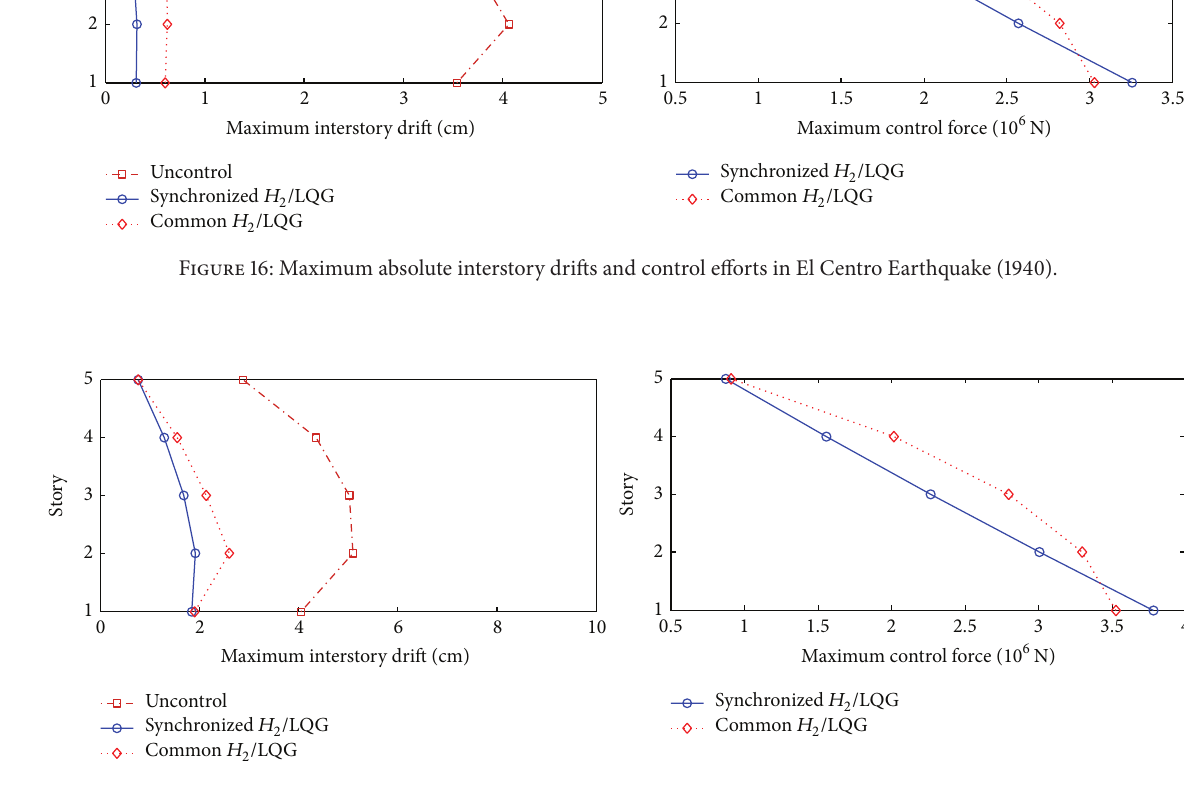
Figure 17: Maximum absolute interstory drifts and control efforts in Bam